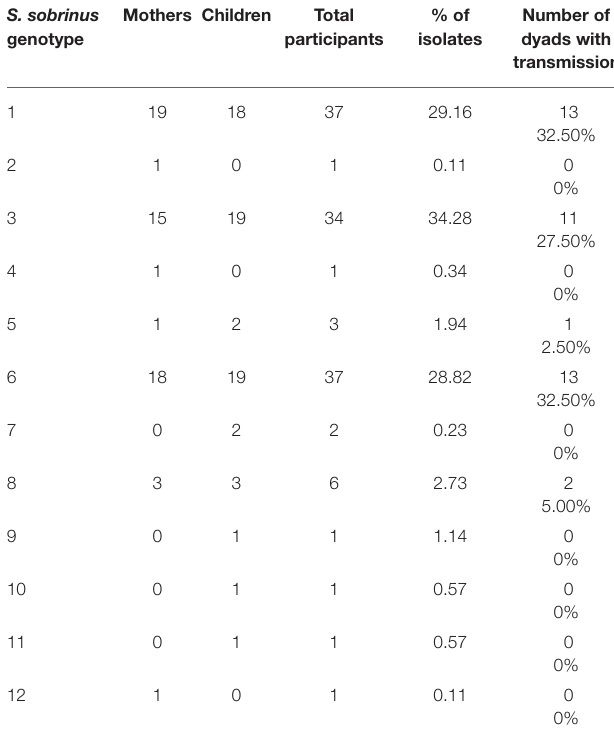
TABLE 4 | S. sobrinus genotype